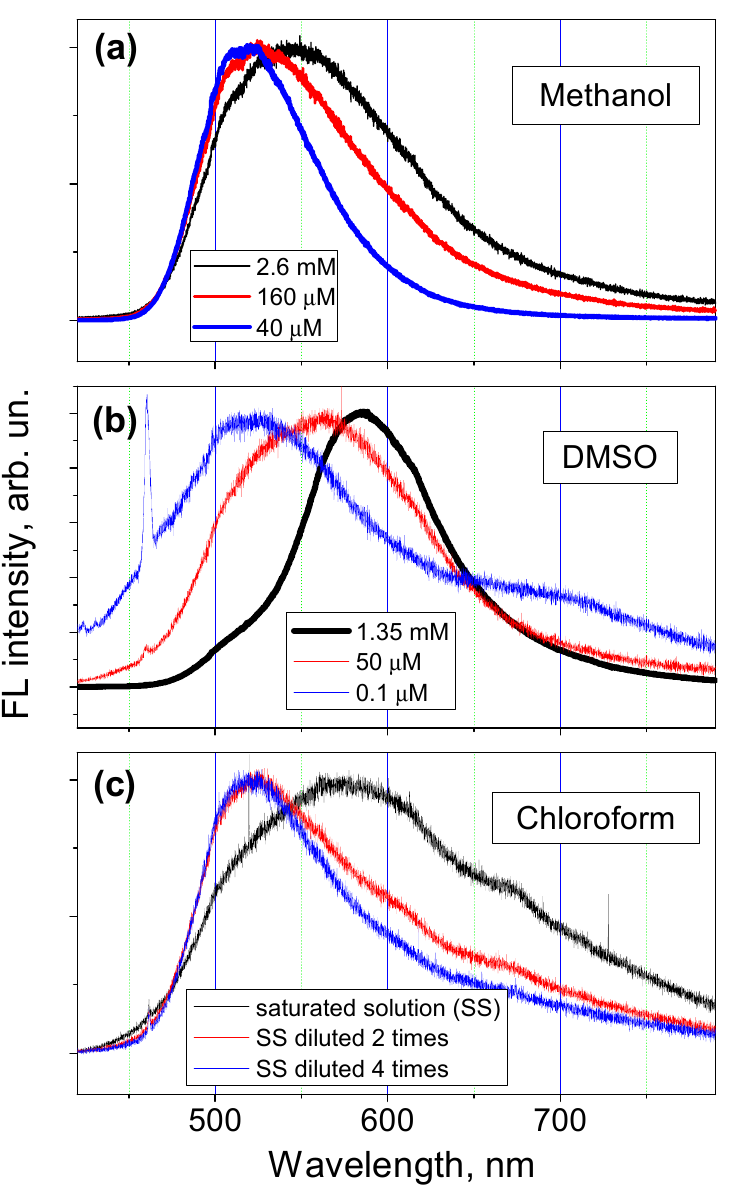
Figure 5. FL emission spectra measured at room temperature on M solutions in: ( a ) methanol, ( b ) DMSO, and ( c ) chloroform, with different concentrations. The sharp emission peak in ( b ) at approximately 460 nm is due to the emission of DMSO solvent. To facilitate comparison, all the spectra were normalized to one by dividing each spectrum by its highest value.